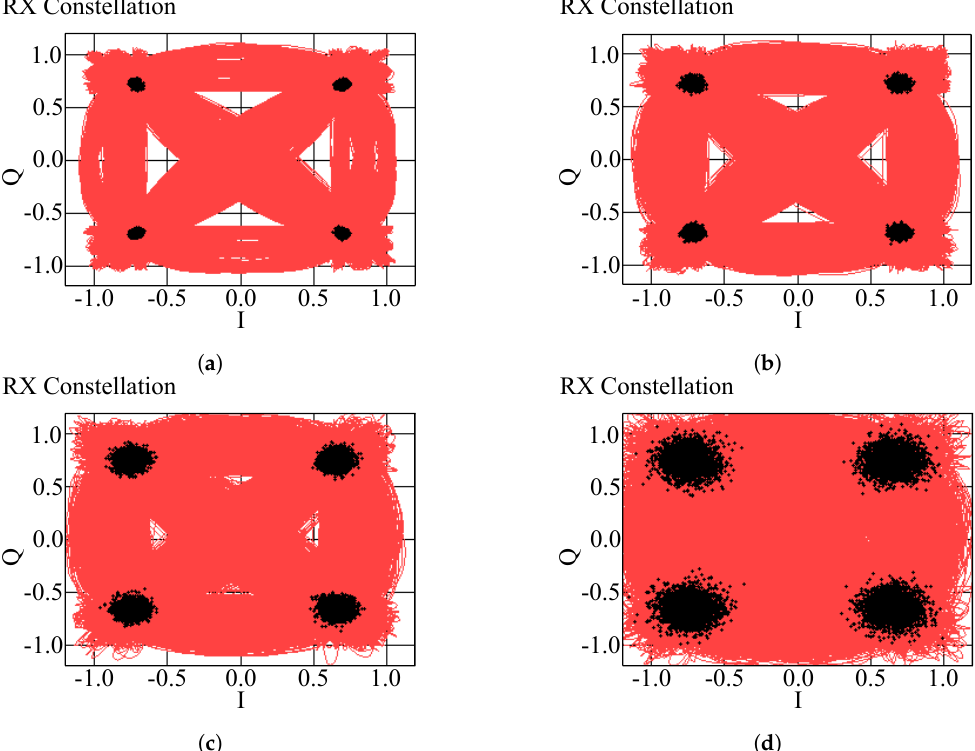
Figure 8. 4-QAM constellation diagrams of ceiling light and different bandwidths: ( a ) 4-QAM,